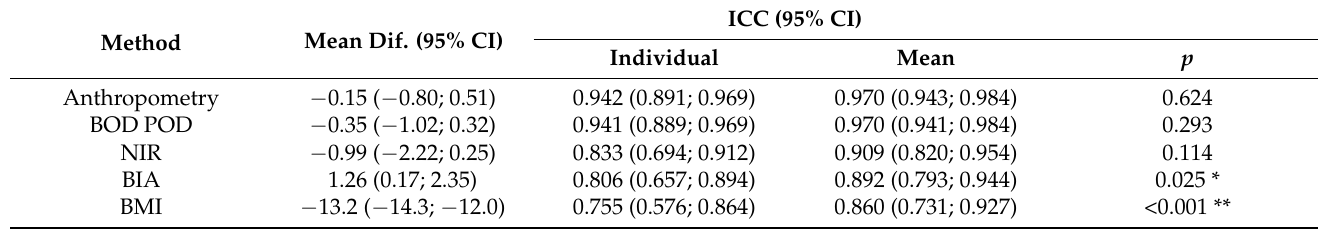
Table 2. Percentage of body fat mean, and individual and mean difference intraclass correlation coefficients with a 95% confidence interval for the different methods compared to